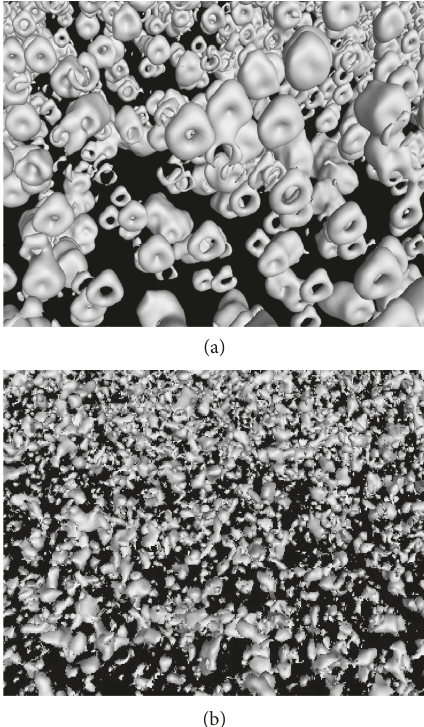
Figure 4: X-ray tomographs of MAP (a) containing rings and (b) ring-free